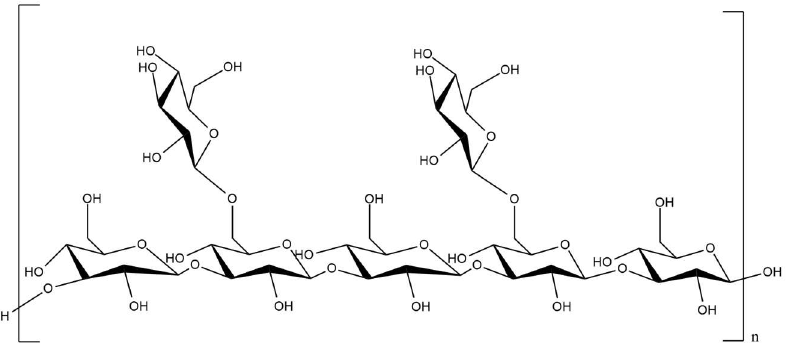
Figure 5. The chemical structure of lentinan.